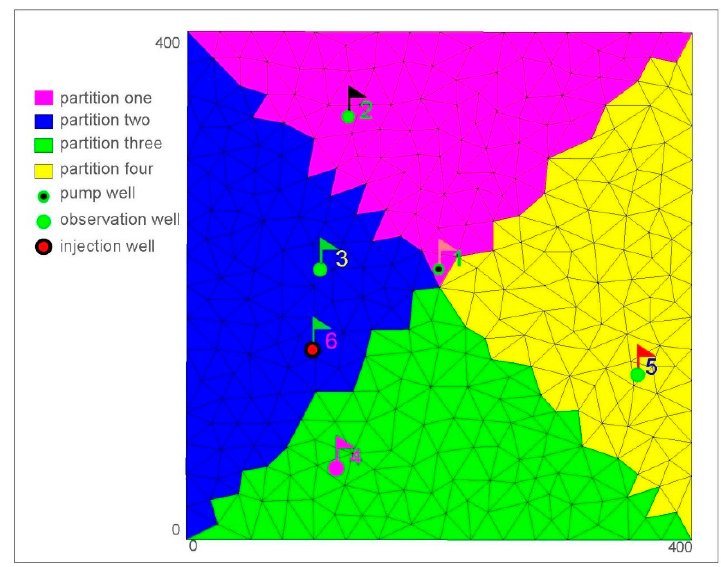
Figure 1. Division graph of ideal groundwater flow model and map showing the locations of the pumping well and the observation wells. (Pumping well: 1; observation wells: 2–5; injection well: 6; length unit: m.)